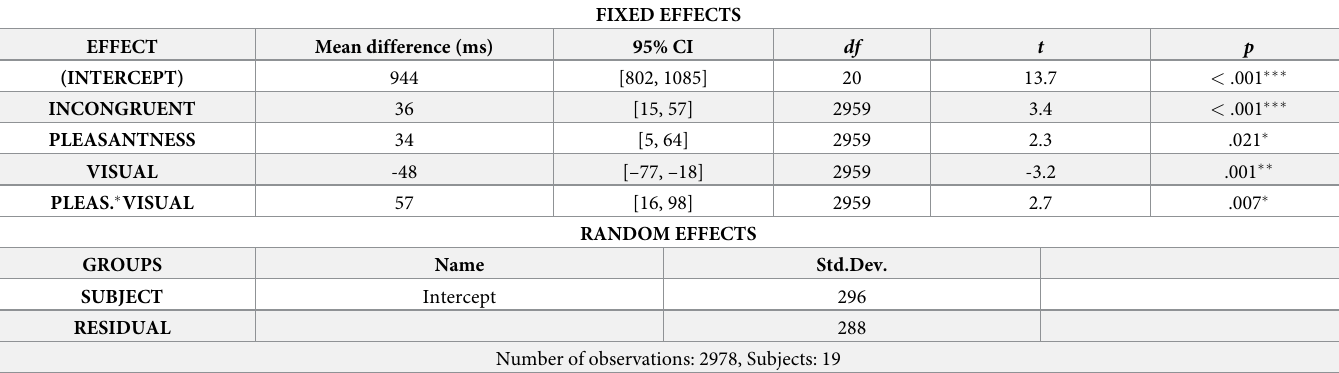
Table 2. Linear mixed model fit by maximum likelihood of the fixed and random effects of Model